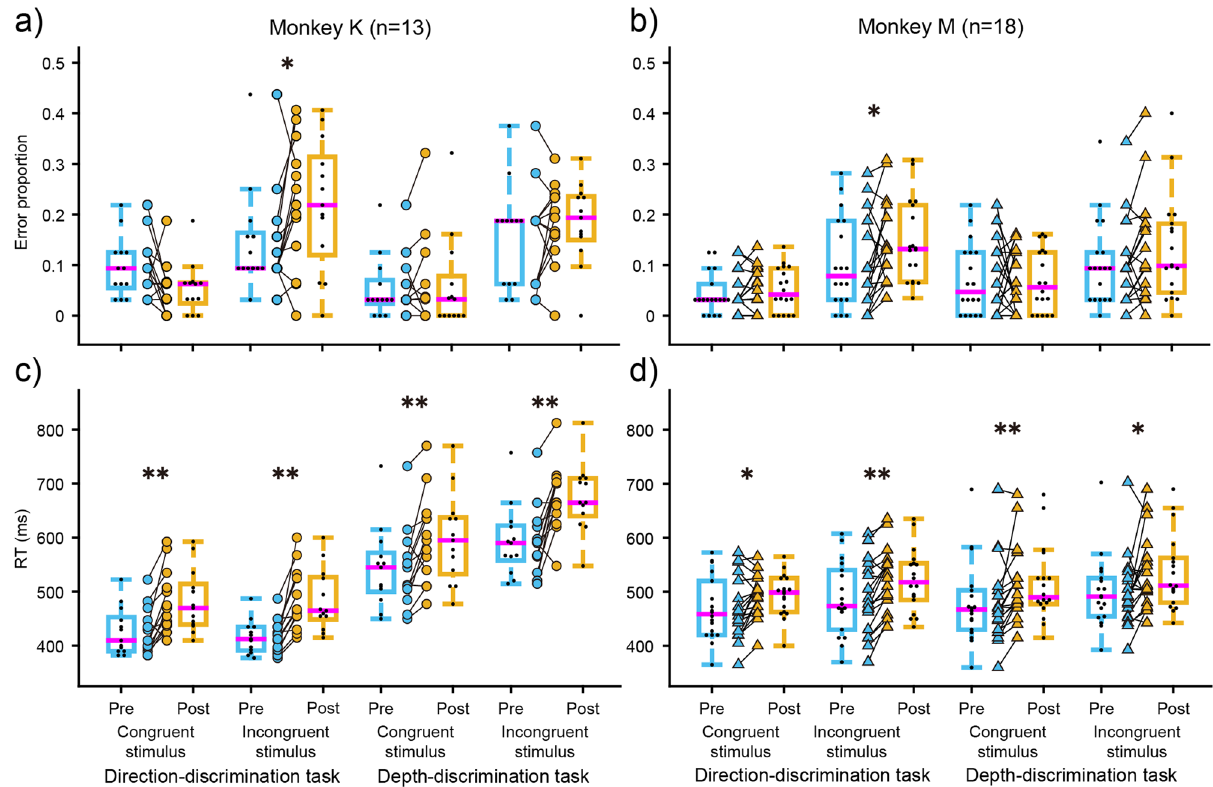
Fig. 2 Effects of ketamine on task-switching performance depended on stimulus congruency and task. Boxplots show error proportion ( a , b ) and reaction time ( c , d ) for congruent and incongruent stimuli with ketamine administration for the direction-discrimination task and the depth-discrimination task. The magenta lines in the box indicate median, the bottom and top edges of the box indicate lower and upper quartiles, the whiskers indicate 1.5x interquartile ranges, and the small dots indicate each experimental data. Circles and triangles denote data for monkey K ( a , c ) and monkey M ( b , d ), respectively. Asterisks indicate statistically signi fi cant results (Wilcoxon signed-rank test; ** p < 0.01, * p <